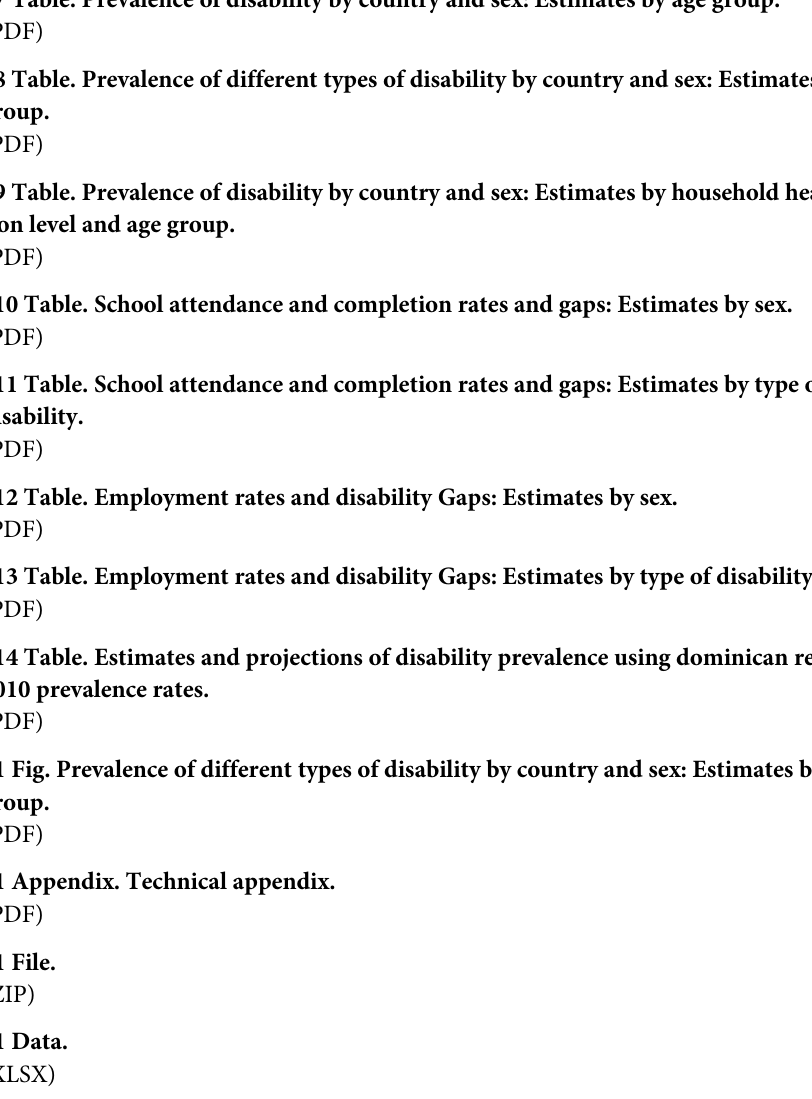
S6 Table. Prevalence of severe disability: Estimates by country and sex. (PDF) S7 Table. Prevalence of disability by country and sex: Estimates by age group. (PDF) S8 Table. Prevalence of different types of disability by country and sex: Estimates by age group. (PDF) S9 Table. Prevalence of disability by country and sex: Estimates by household head educa- tion level and age group. (PDF) S10 Table. School attendance and completion rates and gaps: Estimates by sex. (PDF) S11 Table. School attendance and completion rates and gaps: Estimates by type of disability. (PDF) S12 Table. Employment rates and disability Gaps: Estimates by sex. (PDF) S13 Table. Employment rates and disability Gaps: Estimates by type of disability. (PDF) S14 Table. Estimates and projections of disability prevalence using dominican republic 2010 prevalence rates. (PDF) S1 Fig. Prevalence of different types of disability by country and sex: Estimates by age group.